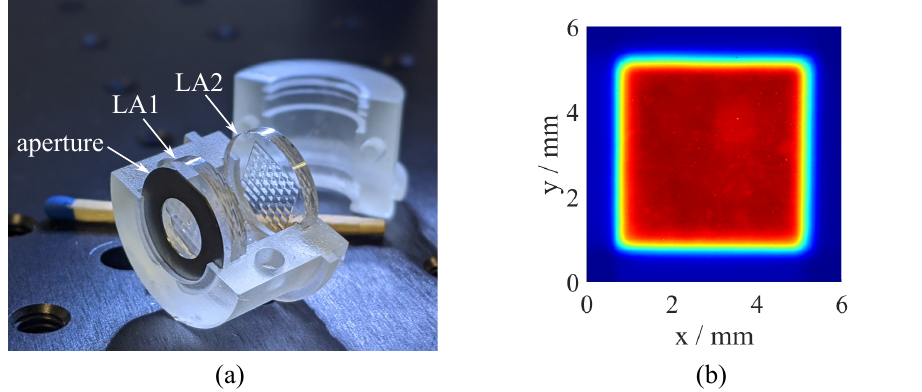
Figure 7. ( a ) Final beam shaping module consisting of two lens arrays and an aperture, assembled within a 3D printed housing and ( b ) Top-Hat beam profile formed by the beam shaping